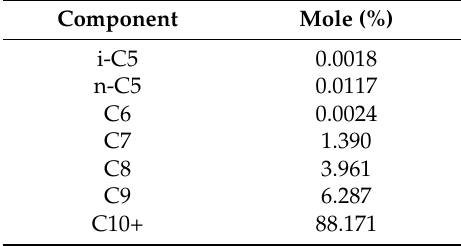
Table 3. Composition of the North Sea crude oil.